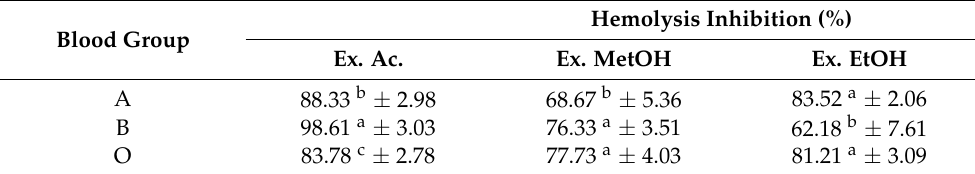
Table 5. Antihemolytic activity of N. incerta extracts against the oxidative hemolysis induced by AAPH on different ABO blood